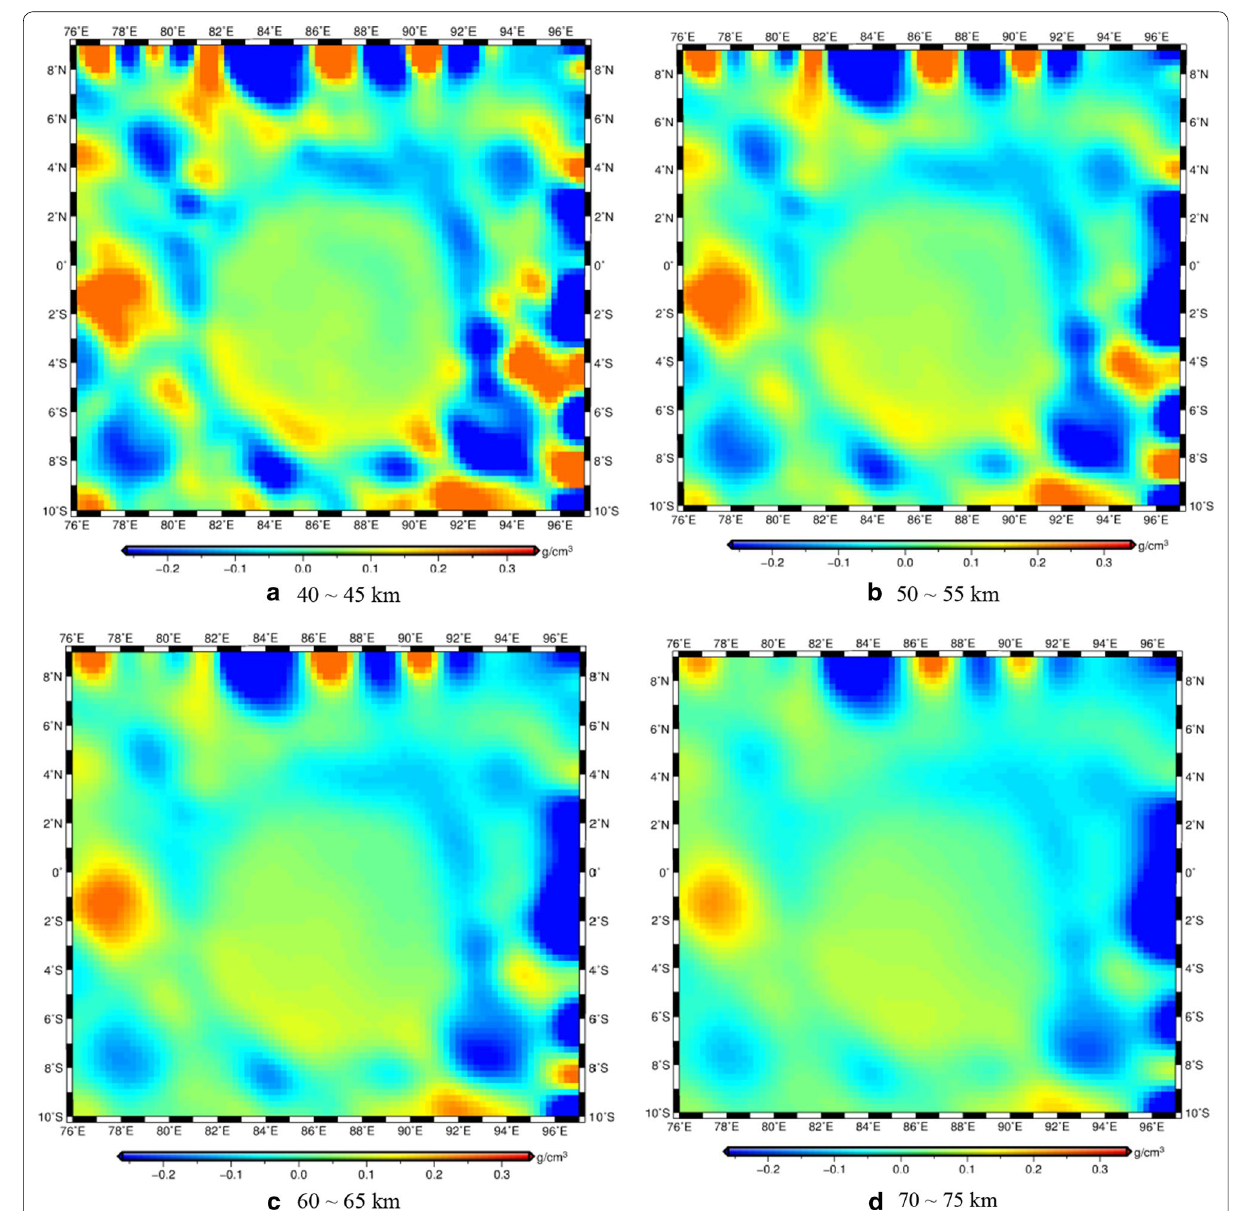
Fig. 17 Relative density distribution for different depths at Mare Smythii area, a , b , c and d are 40 ~ 45 km, 50 ~ 55 km, 60 ~ 65 km and 70 ~ 75 km,